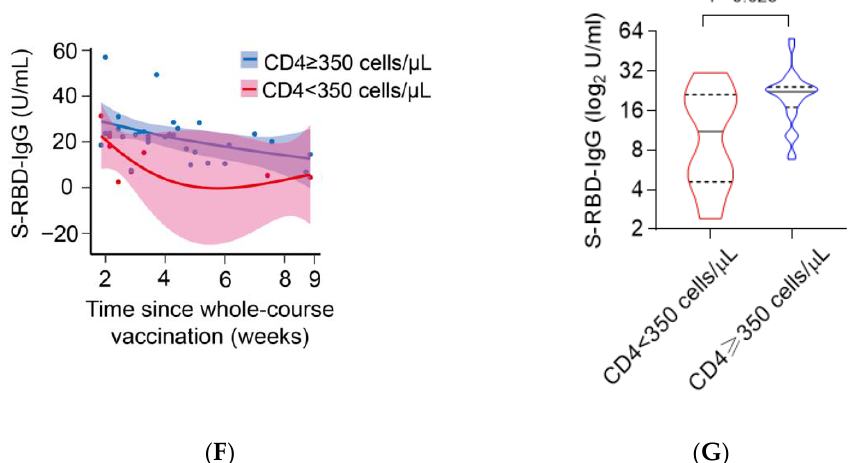
Figure 2. The safety and immunogenicity of COVID-19 vaccine and impact of COVID-19 vaccine on ART efficacy in PLWH. ( A ) Histogram demonstrating the incidence of local and systemic adverse reactions reported within 28 days after each dose of COVID-19 vaccine in PLWH ( n = 219). ( B ) CD4 + T cell counts measured before and after vaccination against COVID-19 or during the same period in vaccinated PLWH ( n = 219) and unvaccinated PLWH ( n = 159). ( C ) The percentage of VL remained to be “TND” in vaccinated PLWH ( n = 219) and unvaccinated PLWH ( n = 159). ( D ) S-RBD-IgG titers after the second dose of the CoronaVac vaccine in PLWH group ( n = 55) and HC group ( n = 21). ( E ) Line plot demonstrating the dynamic trend of S-RBD-IgG titers (loess smoothed normalized counts SE) over time after the second dose of the CoronaVac vaccine in PLWH group ( n = 55) and HC group ( n = 21). ( F ) Line plot demonstrating the dynamic trend of S-RBD-IgG titers (loess smoothed nor- malized counts SE) over time after the second dose of the CoronaVac vaccine in immunological responders (CD4 + T cell counts > 350 cells/μL, n = 31) and poor immunological responders (CD4 + T cell counts ≤ 350 cells/μL, n = 8). ( G ) S-RBD-IgG titers after the second dose of the CoronaVac vaccine in immunological responders (CD4 + T cell counts >350 cells/μL, n = 31) and poor immunological responders (CD4 + T cell counts ≤ 350 cells/μL, n = 8). PLWH: people living with HIV; HC: health